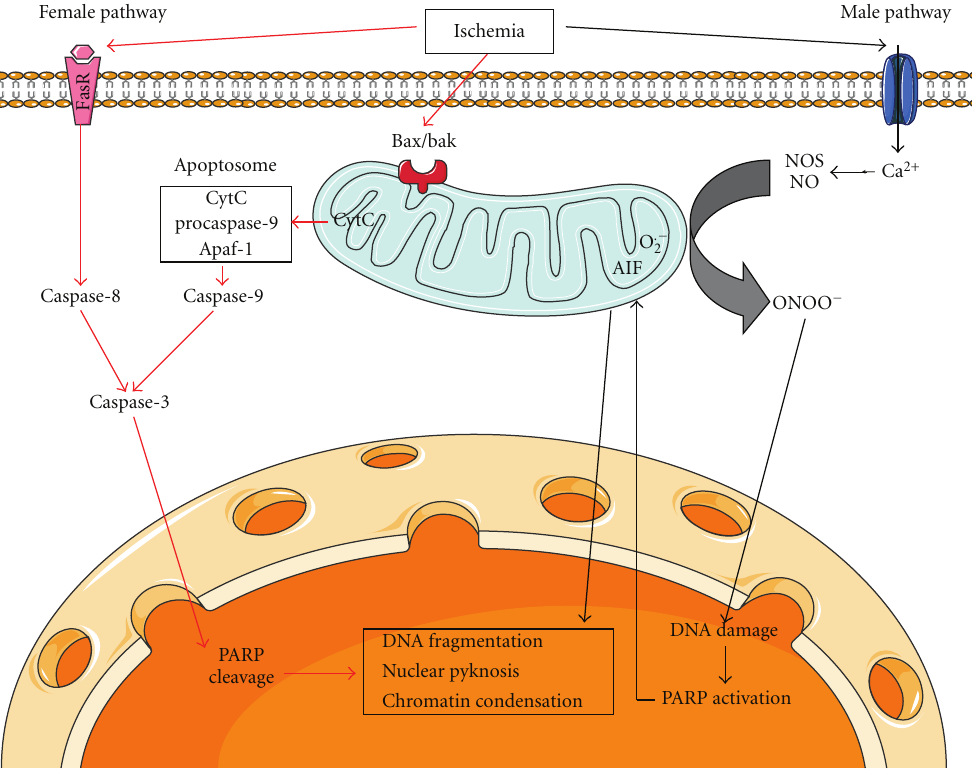
Figure 4: Mechanisms of PARP-AIF and cytochrome C-caspase-mediated cell death pathways predominant, respectively, in male and female brains after ischemia. The figure was produced using Servier Medical